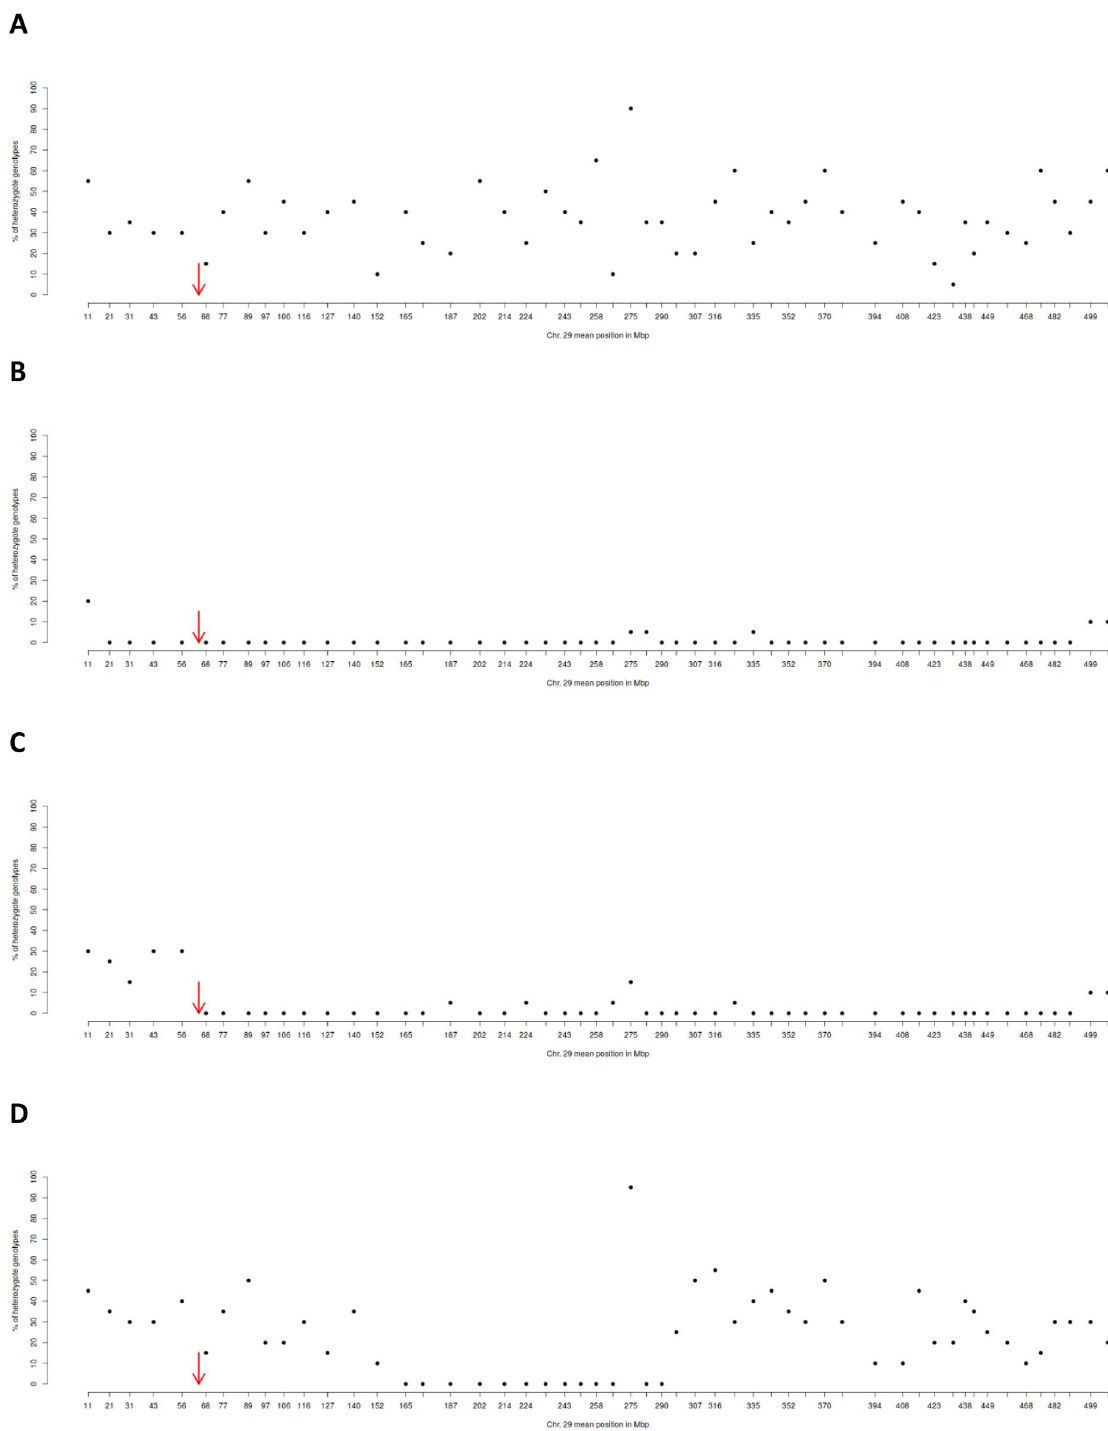
Figure 3. Representative graphical outline of embryos identified to represent homozygous full edits. Proportion of SNP-heterosygosity along chromosomes 29 is reported for DNA-windows with a red arrow indicating the Cas9 target site. Each spot represents state of heterosygosity of one window encompassing a total of 20 SNP- marker. All in all 11 out of 23 embryos showed no Loss-of-heterozygosity in chromosome 29, containing the target side, and were therefore classified as non-disrupted as demonstrated exemplarily in ( A ). Conversely, 1 embryo showed Loss-of-heterozygosity along the entire target-side arm of the chromosome and were therefore classified as Loss-of-chromosome ( B ) whereas 3 embryos displaying losses of heterozygosity distal the target site were classified as Loss-of-chromosomal arms ( C ). A total of 6 Embryos displaying Loss-of-heterozygosity along large segments within the chromosome were classified as Loss-of-chromosomal section ( D